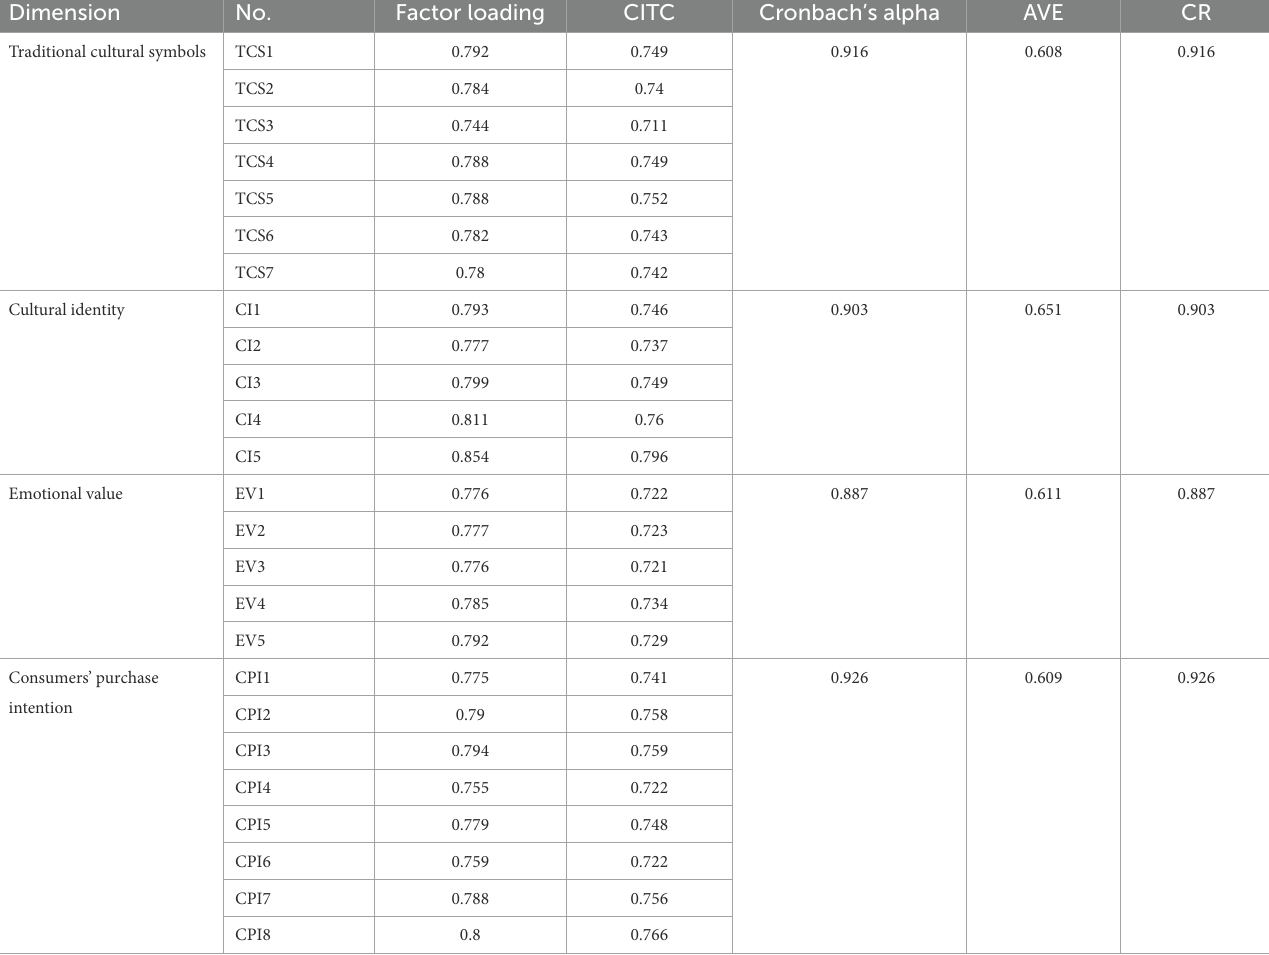
TABLE 3 Factor loading, Cronbach’s alpha, CR, and AVE. Dimension